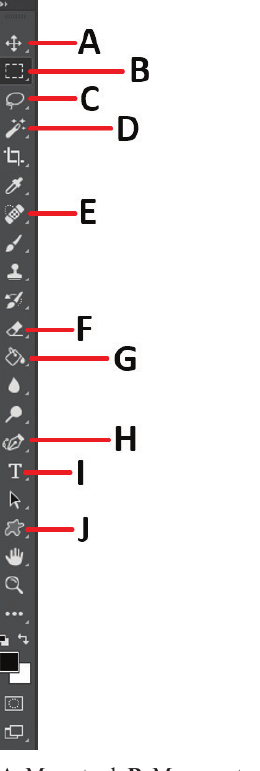
Figure 3. Tools panel. A . Move tool; B . Marquee tools; C . Lasso tool; D . Magic Wand; E . Spot Healing Brush tool; F . Eraser tool; G . Paint Bucket tool; H . Pen tool; I . Type tool; J . Shape tool.